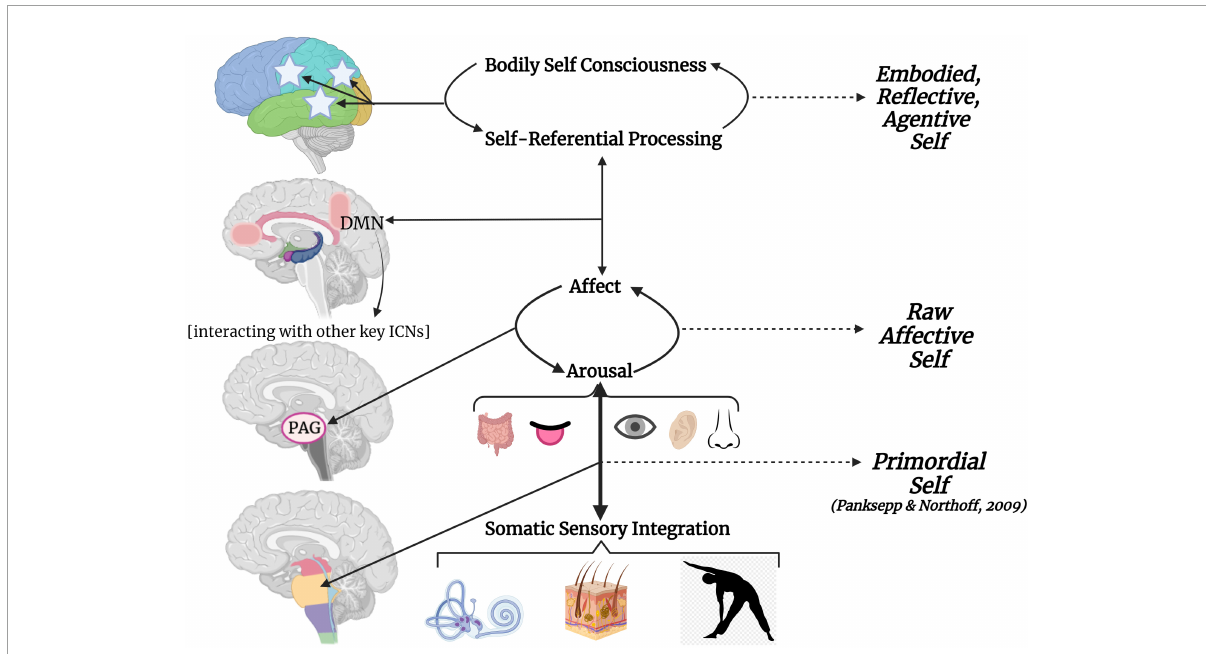
FIGURE10 The embodied, reflective, agentive self grounded in somatic sensory integration. This hierarchical model visualizes how somatic sensory processing provides a foundation for exteroceptive and interoceptive sensory processing, influences arousal, mediates how arousal meets affect, and ultimately impacts higher-order self-referential processing and bodily self-consciousness. The left side of the graphic visualizes how neurodevelopmental vertical integration leads to horizontal integration of the cortex; the right side depicts hierarchical complexity of selfhood. Brainstem-level somatic sensory integration provides a subconscious sense of primordial self as it relates to the physical environment. Somatic sensory processing then mediates how arousal meets affect at the level of the midbrain PAG, giving rise to rudimentary awareness of a raw affective self. The PAG as a node of the SN allows for switching between salience detection and self-referential processing within the cortical midline structures (DMN). The DMN fluidly interacts with other key ICNs (SN, CEN) to influence behavioral states. Horizontal integration from cortical midline to lateral structures elaborate upon self-referential processing giving rise to an embodied, reflective, agentive sense of higher self that is anchored to the body. CEN, central executive network; DMN, default mode network; ICN, intrinsic connectivity network; PAG, periaqueductal gray; SN, salience